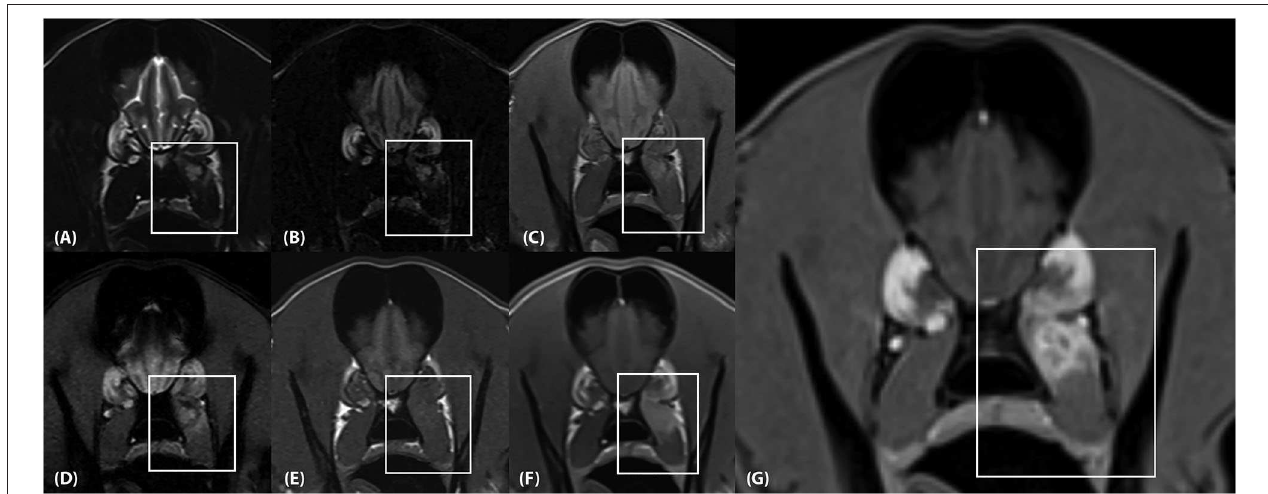
FIGURE 2 | (A) Transverse T2-weighted, (B) T2-FLAIR, (C) PD-weighted, (D) T2*-weighted GRE, (E) T1-weighted pre contrast, (F) T1-weighted post contrast and (G) T1-weighted Volume Interpolated GRE images with fat saturation (“VIBE”) at the level of the frontal lobes. There is an ∼ 2.5 × 1.3 × 1.2cm (length × height × width) lesion located within the dorsal aspect of the left medial pterygoid muscle (box) which mostly follows the normal muscle contour aside from a focal region of muscle expansion in the dorsal aspect of the lesion. (A,B) , The lesion is mildly heterogeneously T2 and FLAIR hyperintense, (C) mildly heterogeneously PD hyperintense, (D) heterogeneously T2* hyperintense, and (E) T1 iso-to mildly hyperintense. (F,G) The lesion is strongly and heterogeneously contrast